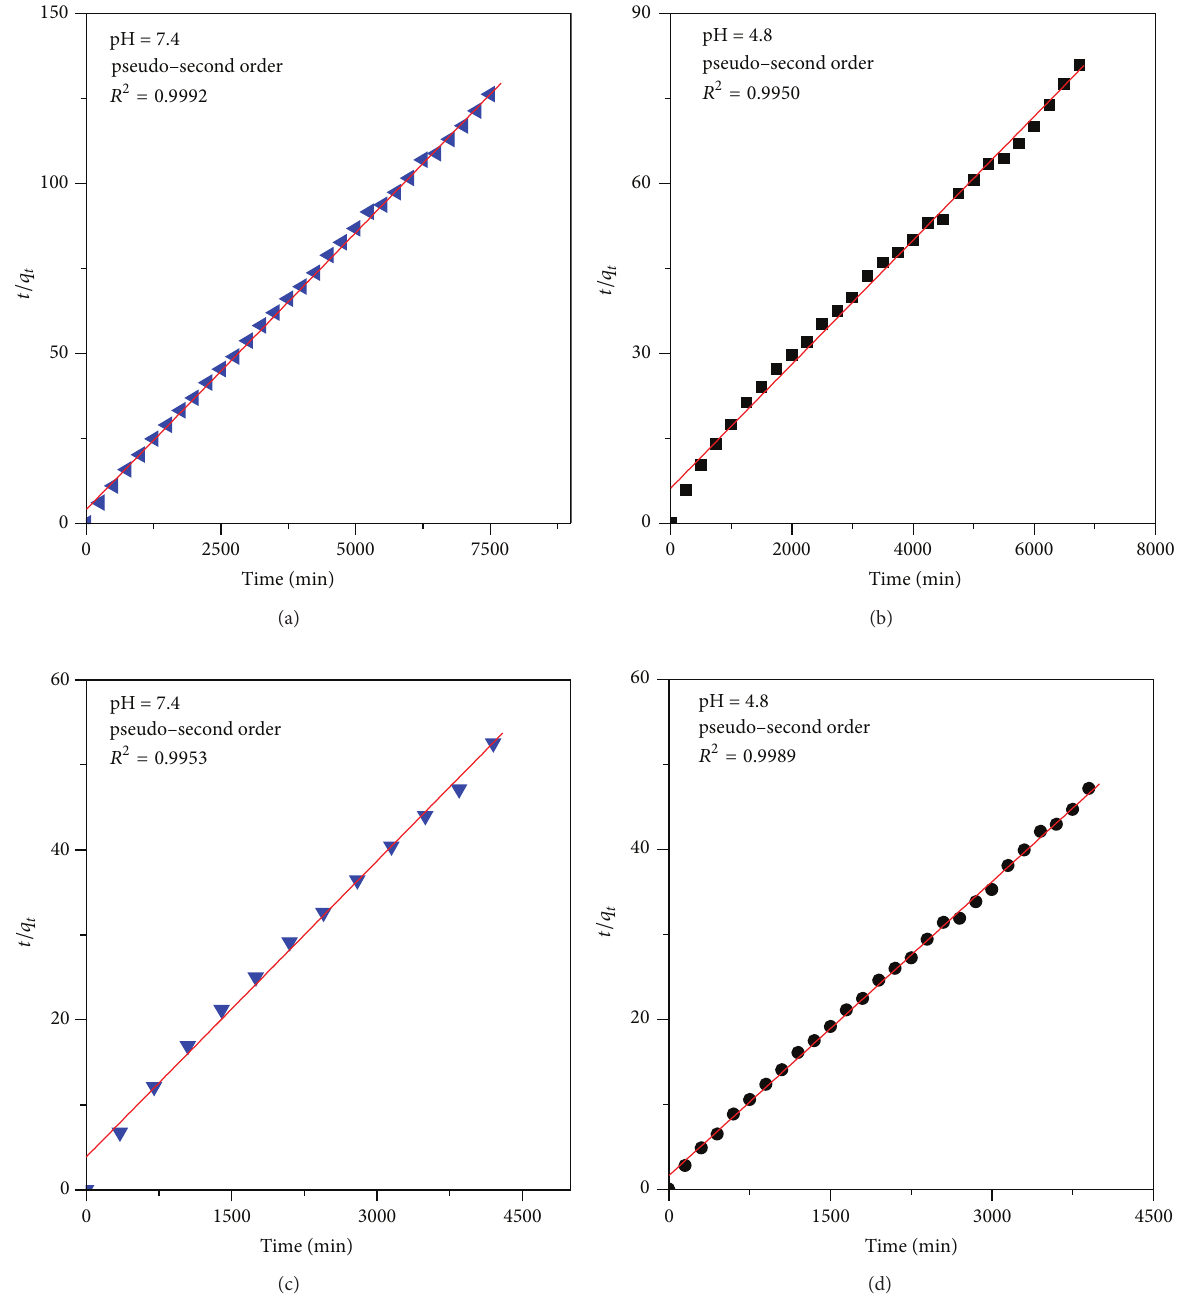
Figure 7: Fitting the data of GA release from FPEGG into different solutions to the pseudo-second-order kinetics for pH 7.4 (a) and pH 4.8 (b) and fitting data of GA released from FPVAG into different solutions to the pseudo-second-order kinetics for pH 7.4 (c) and pH 4.8